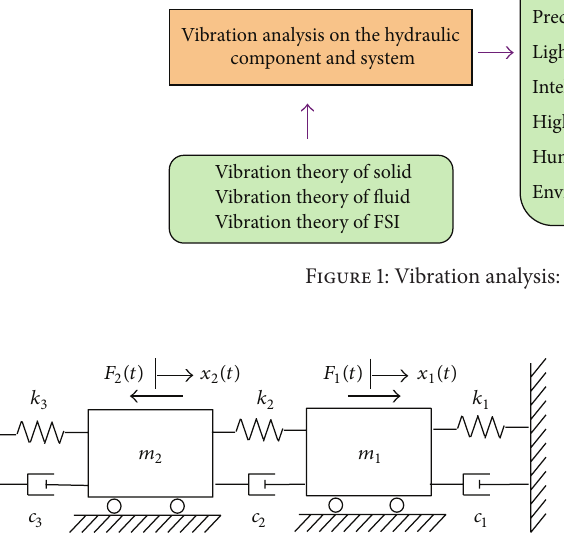
Figure 2: Vibration model for the two degrees of freedom of a hydraulic plunger